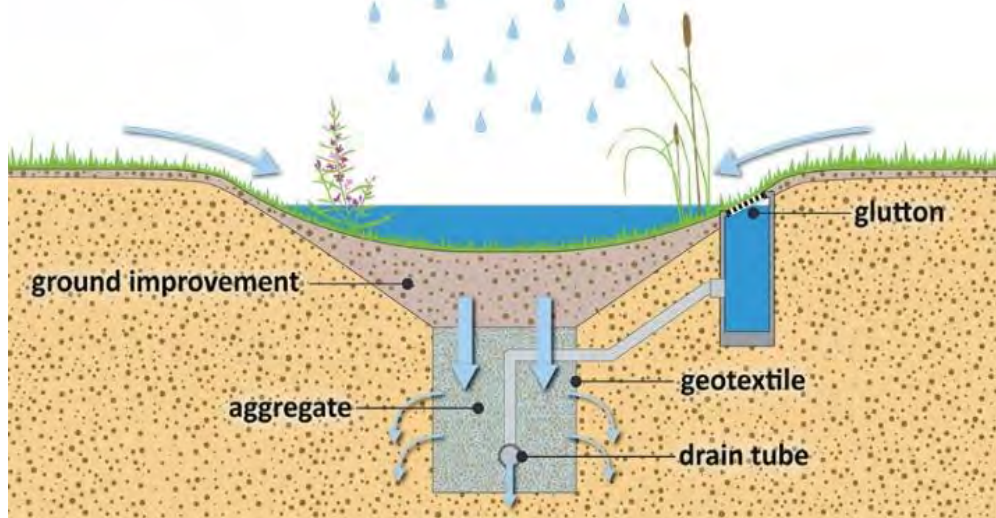
Fig.10: Section scheme of bioswale when it is wet. (Boogaard et al,